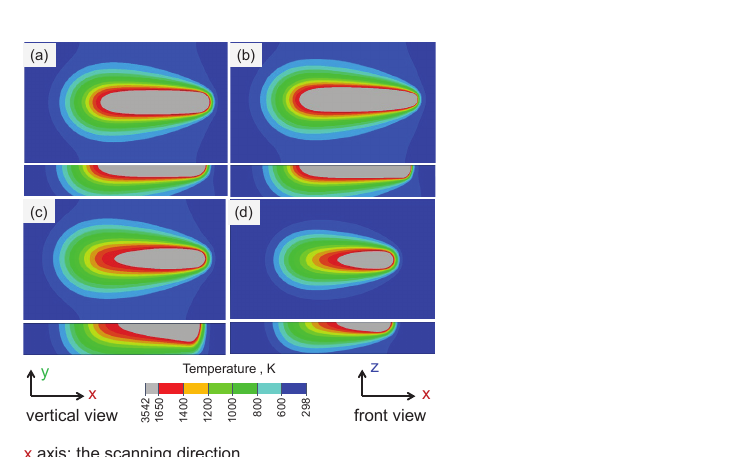
Figure 5. The transient temperature distribution on the top surface (top view) and lengthwise section (front view) of the molten pool during the SLM process with different heat source power and parameters. The heat source parameters c = 2 a , f f / r = 1, ( a ) a = 0.05 mm, b = 0.06 mm, P = 190 W; ( b ) a = 0.025 mm, b = 0.06 mm, P = 190 W; ( c ) a = 0.05 mm, b = 0.15 mm, P = 190 W; ( d ) a = 0.05 mm, b = 0.06 mm, P = 100 W;